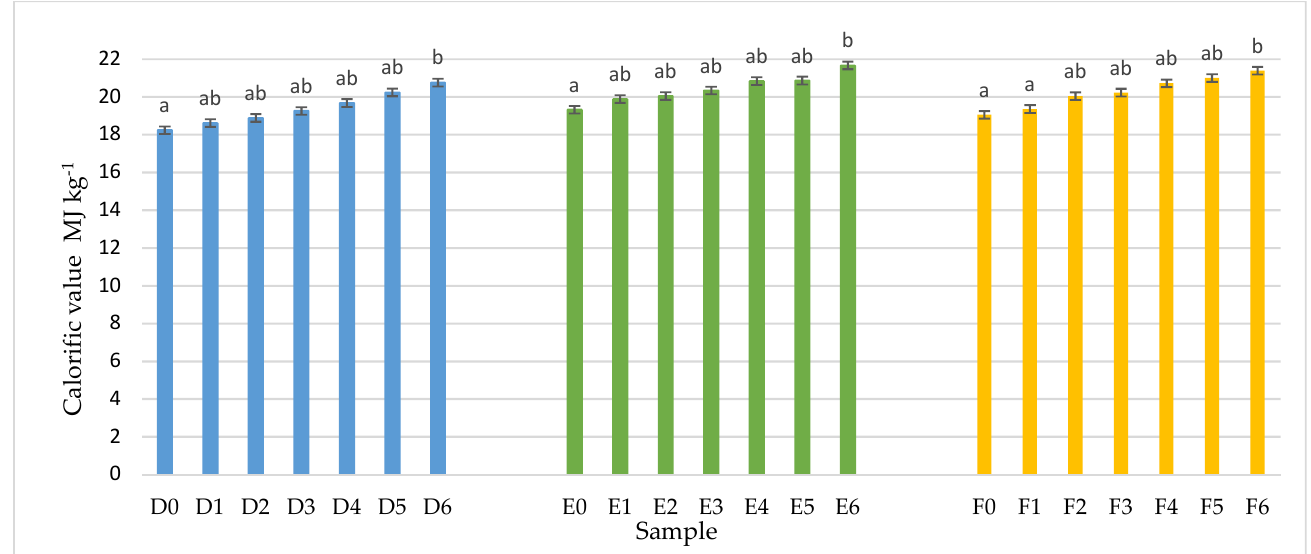
Figure 4. Calorific value of samples of coniferous and coniferous–deciduous wood pellets before and after waste cooking oil was added by spraying. Statistically significant differences marked by different letters ( p ≤ 0.05). Differences between average values marked with the same letters (a,b) are not statistically significant at the level of p ≤ 0.05 according to the Duncan test. The data were analysed separately for each type of pellet.